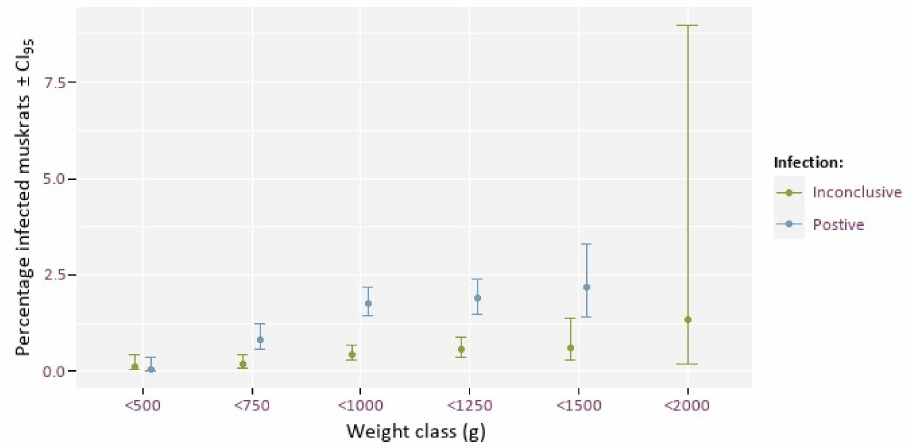
Figure 5. Percentage of muskrats with positive (blue) and inconclusive (green) EM presence by weight class